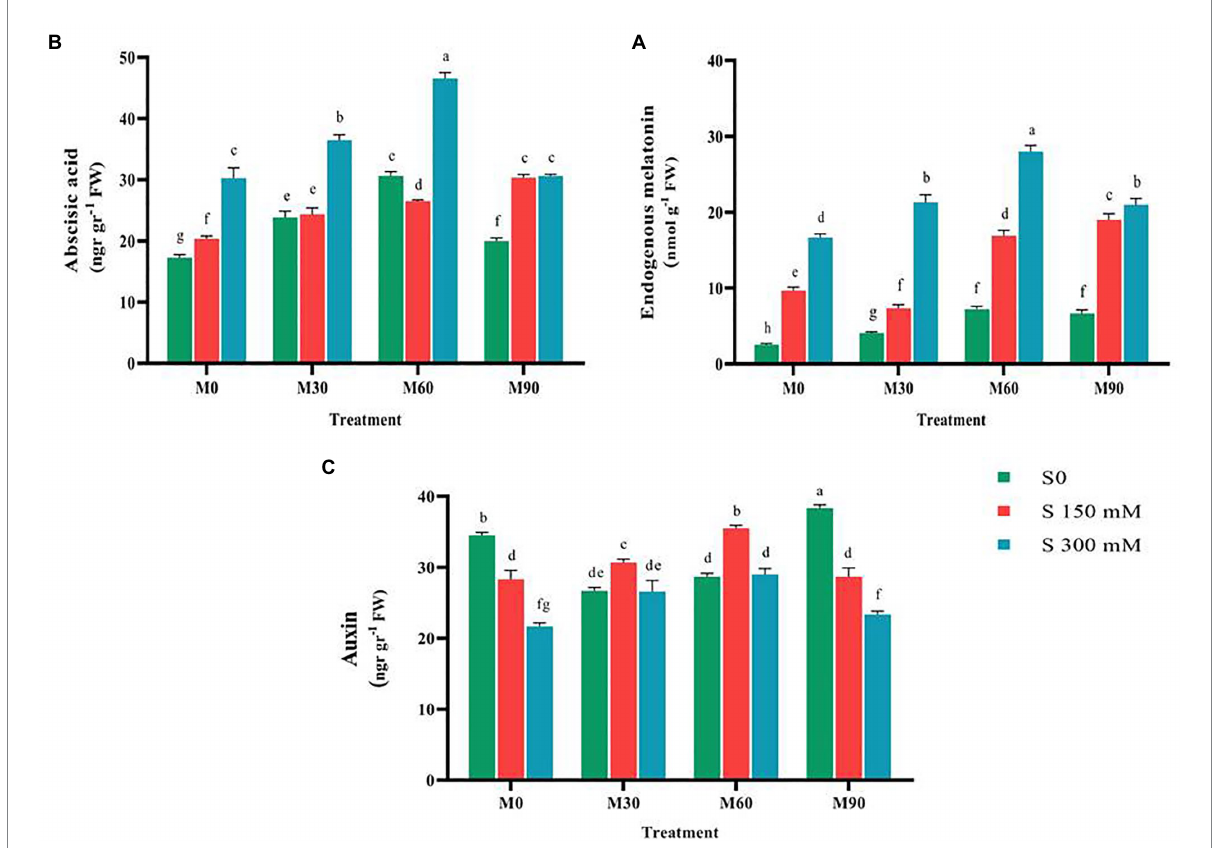
FIGURE 3 The mean comparison effects of melatonin concentrations and different levels of NaCl on (A) Endogenous melatonin content, (B) Abscisic acid content, (C) Auxin content. Duncan method at 1% probability level was applied to compare mean values. The columns having similar letters had no significant